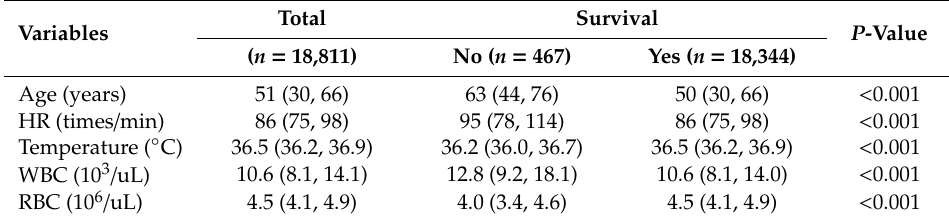
Table 1. Continuous variables of patient characteristics of those trauma patients who survived or not.